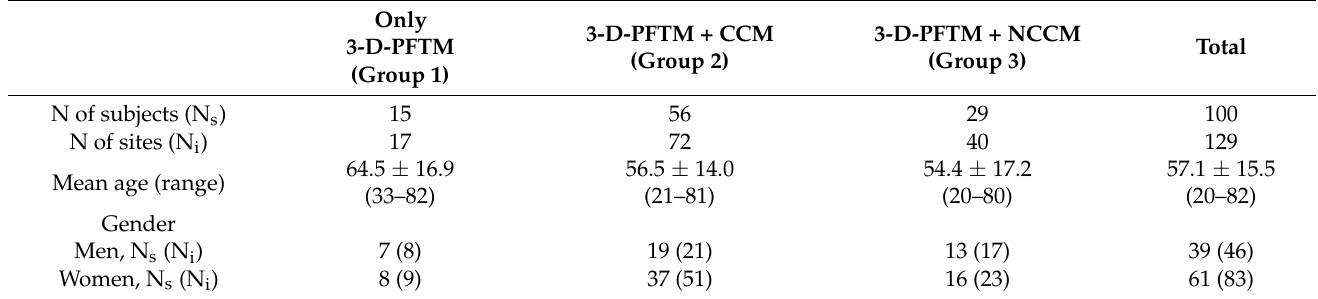
Table 1. Characteristics of the